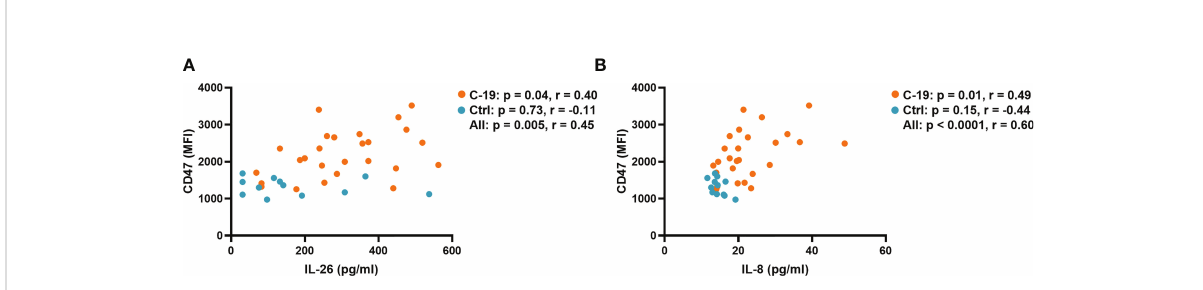
FIGURE 2 The plasma concentrations of IL-26 and IL-8 are associated with the surface expression of CD47 on blood neutrophils in acute COVID-19. Spearman correlation analyses of the plasma concentrations of (A) IL-26 and (B) IL-8 with the surface expression of CD47 on blood neutrophils from the COVID-19 (orange) and Control (blue) groups.